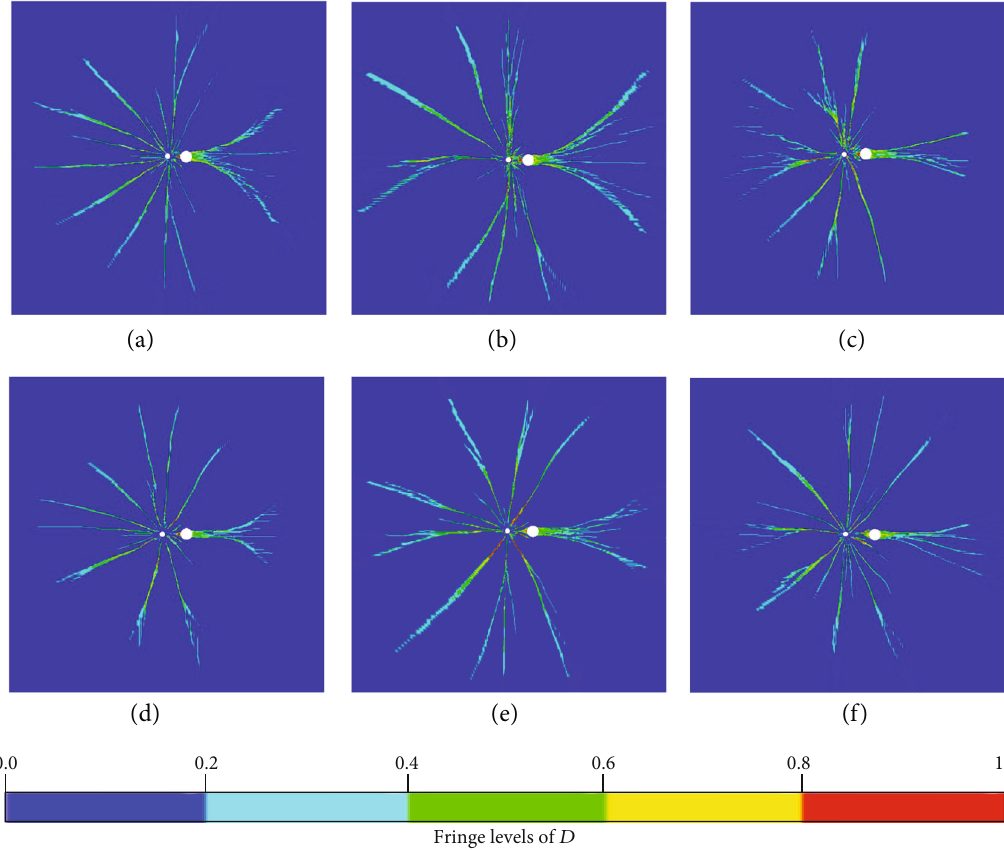
Figure 5: Tension damage of prime cut blasting under di ff erent burdens: (a) scheme 1, (b) scheme 2, (c) scheme 3, (d) scheme 4, (e) scheme 5, and (f) scheme